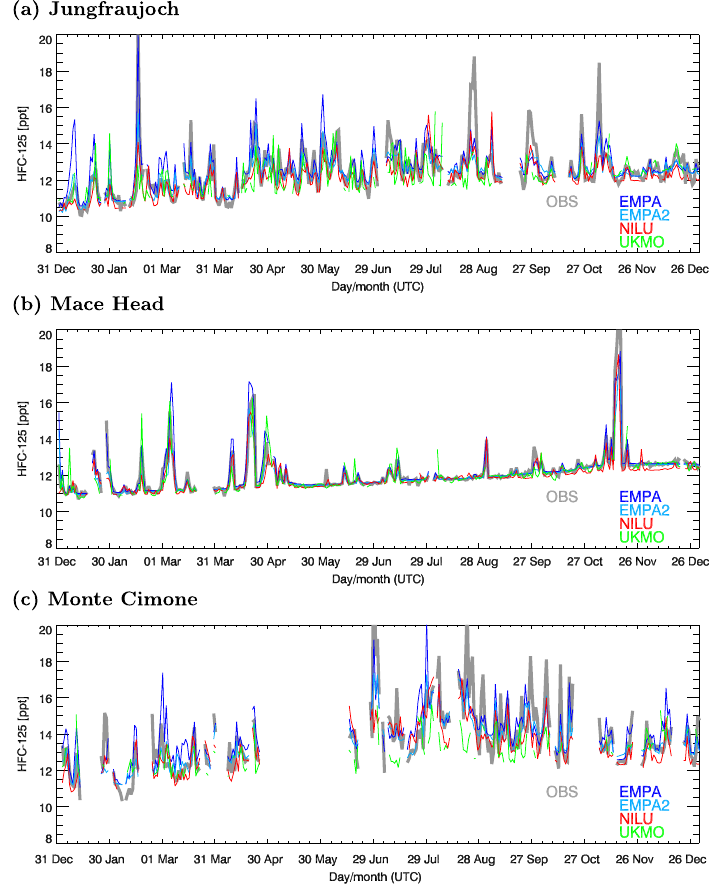
Figure 3. Same as Fig. 2 but for posterior